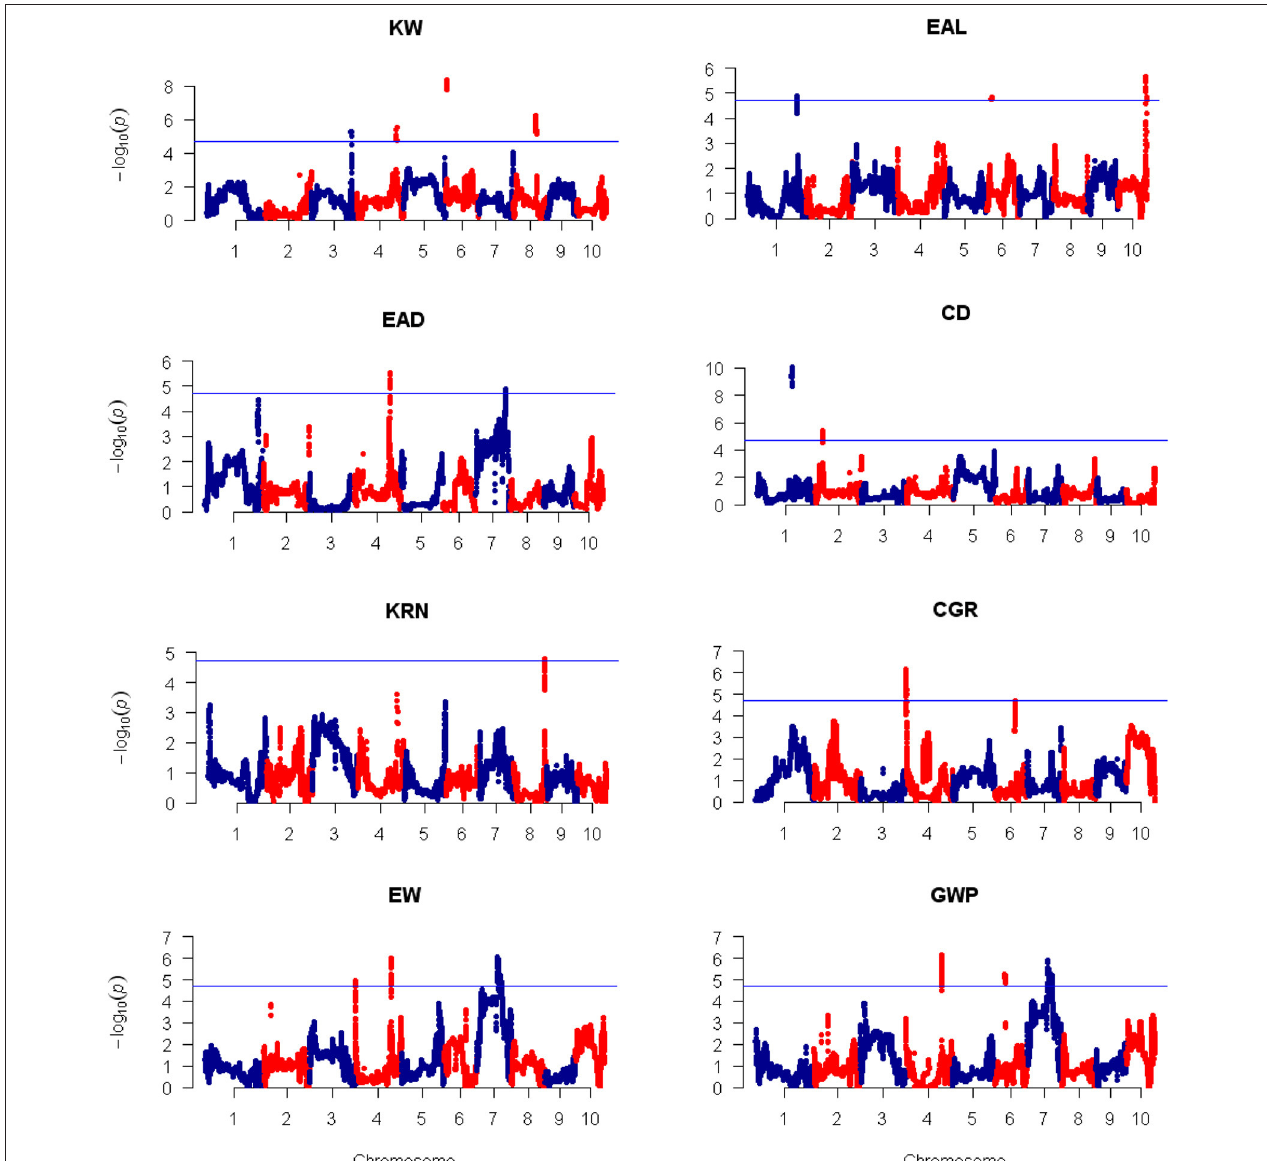
FIGURE 4 | Plots of test statistic − Log10( p ) against genome location for eight traits of maize using the CIM method. The horizontal blue line of each panel is the critical value of the test statistic generated from 1,000 permuted samples. The eight traits are: ear length (EAL), ear diameter (EAD), cob diameter (CD), kernel row number (KRN), corn grains per row (CGR), ear weight (EW), and grain yield per plant (GWP).